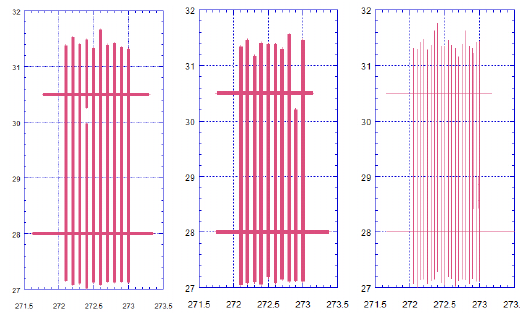
Figure 1. Flighttracksatflightaltitude1700,6300and11000m(from left to right)